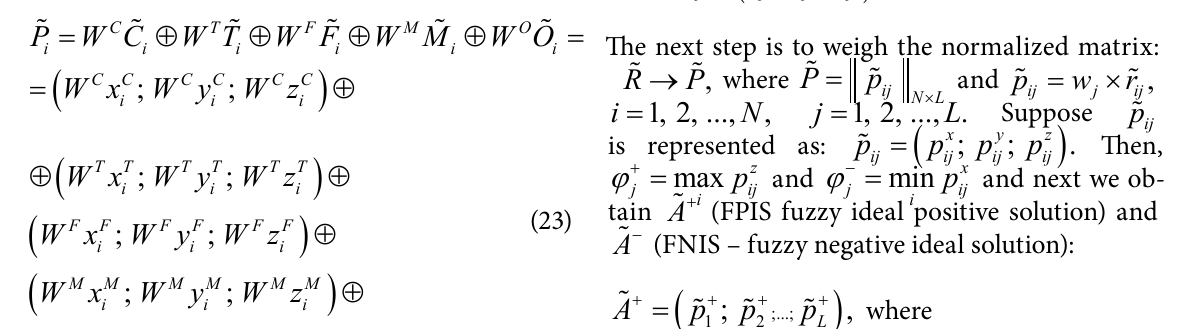
Table 2. Evaluation sub-crietria weights for fuzzy